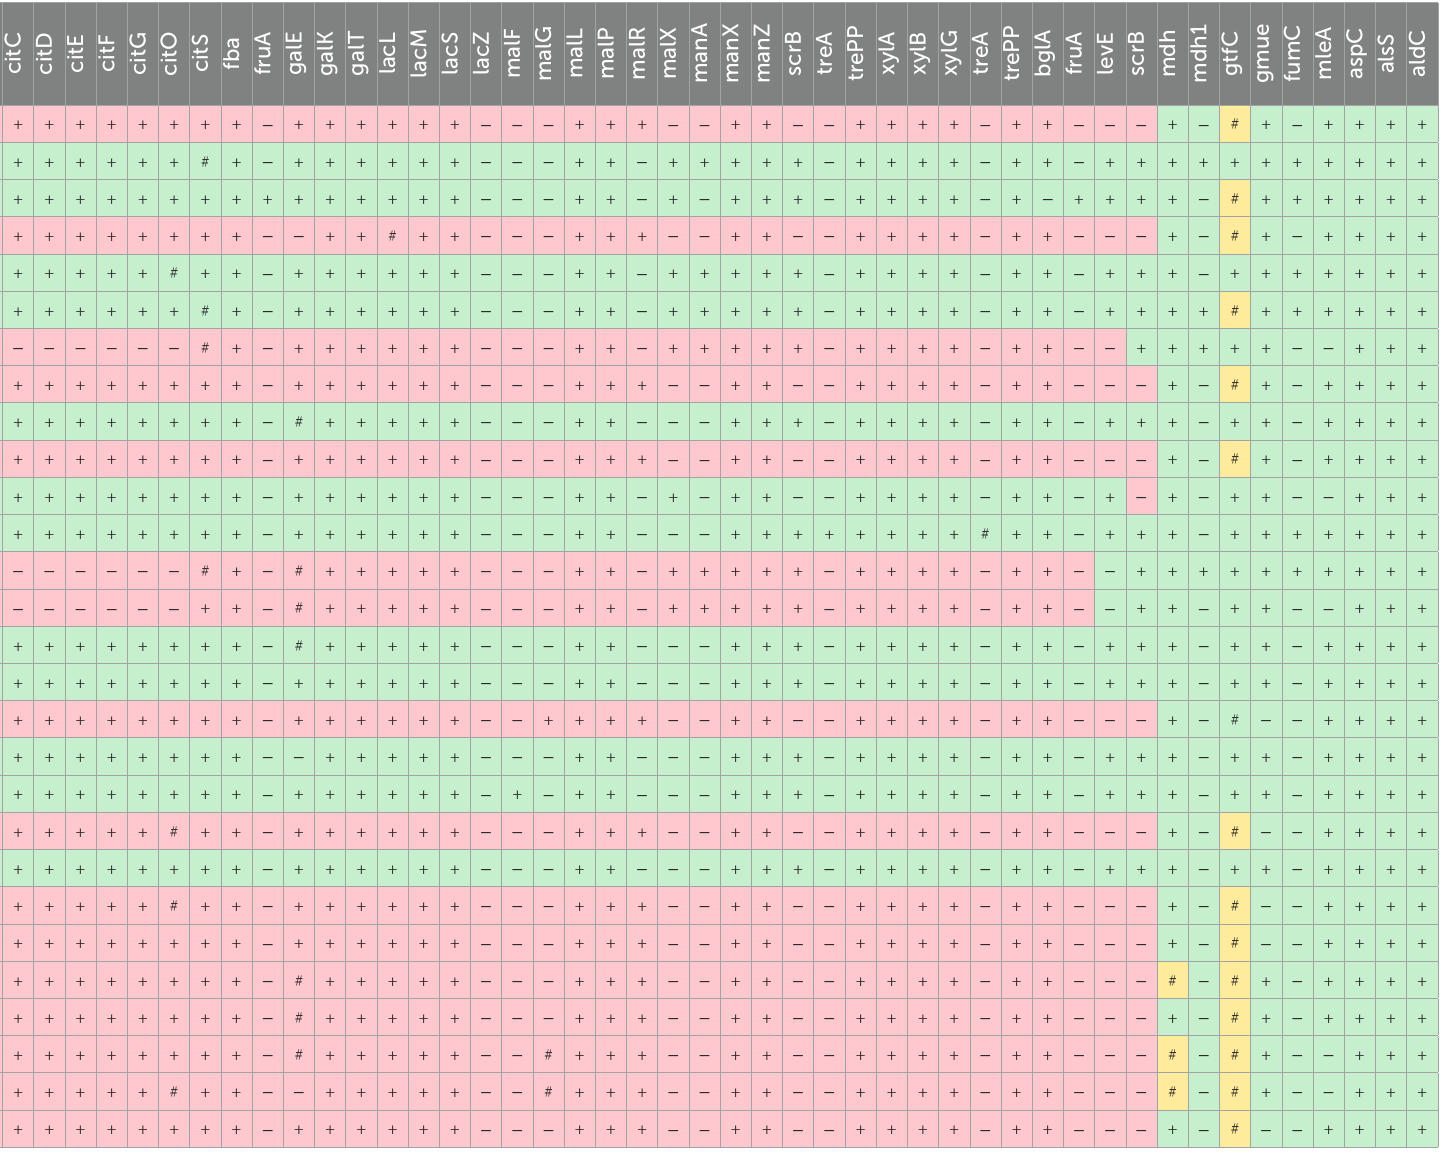
TABLE 2 Presence (+) and absence ( − ) of putative carbohydrate metabolism, citrate metabolism, malate metabolism, and mannitol metabolism of 38 Ln. pseudomesenteroides .